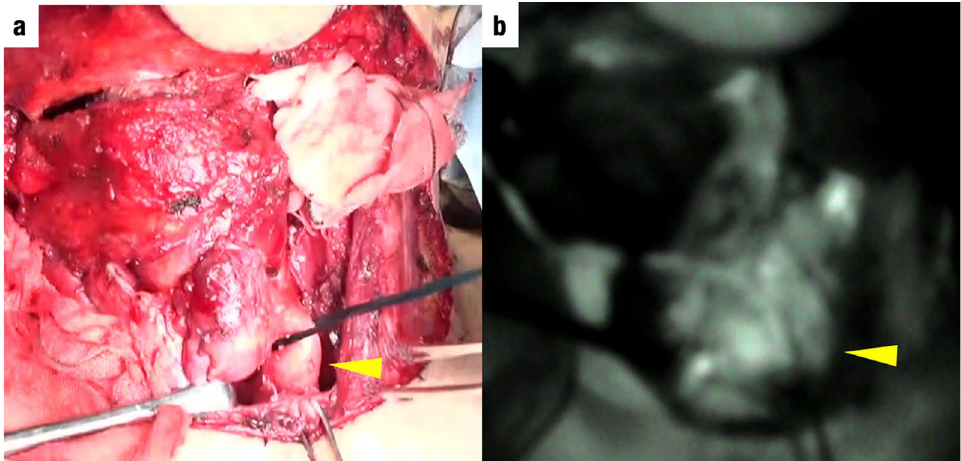
Fig. 3 Intraoperative findings. a Image showing no color defects in the remnant cervical esophagus. b Image of the remnant cervical esophagus stained using intravenous indocyanine green after ligation of the oral side of the remnant esophagus with bilateral cervical